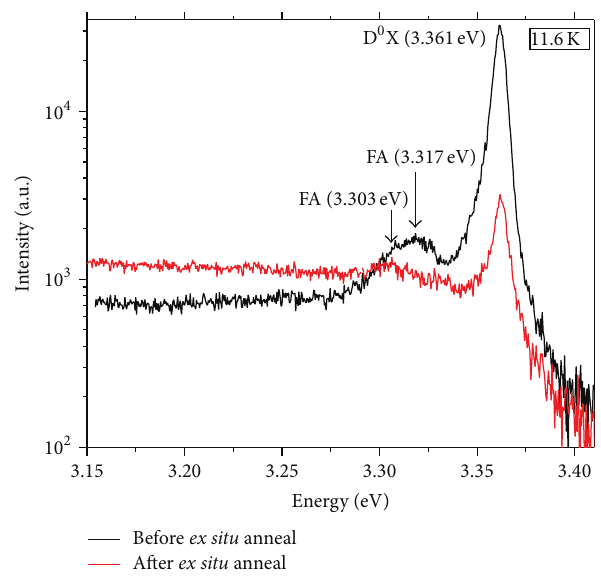
Figure 7: 11.6K PL spectra of p-type ZnO before and after the ex situ 800 ∘ C O 2 anneal.